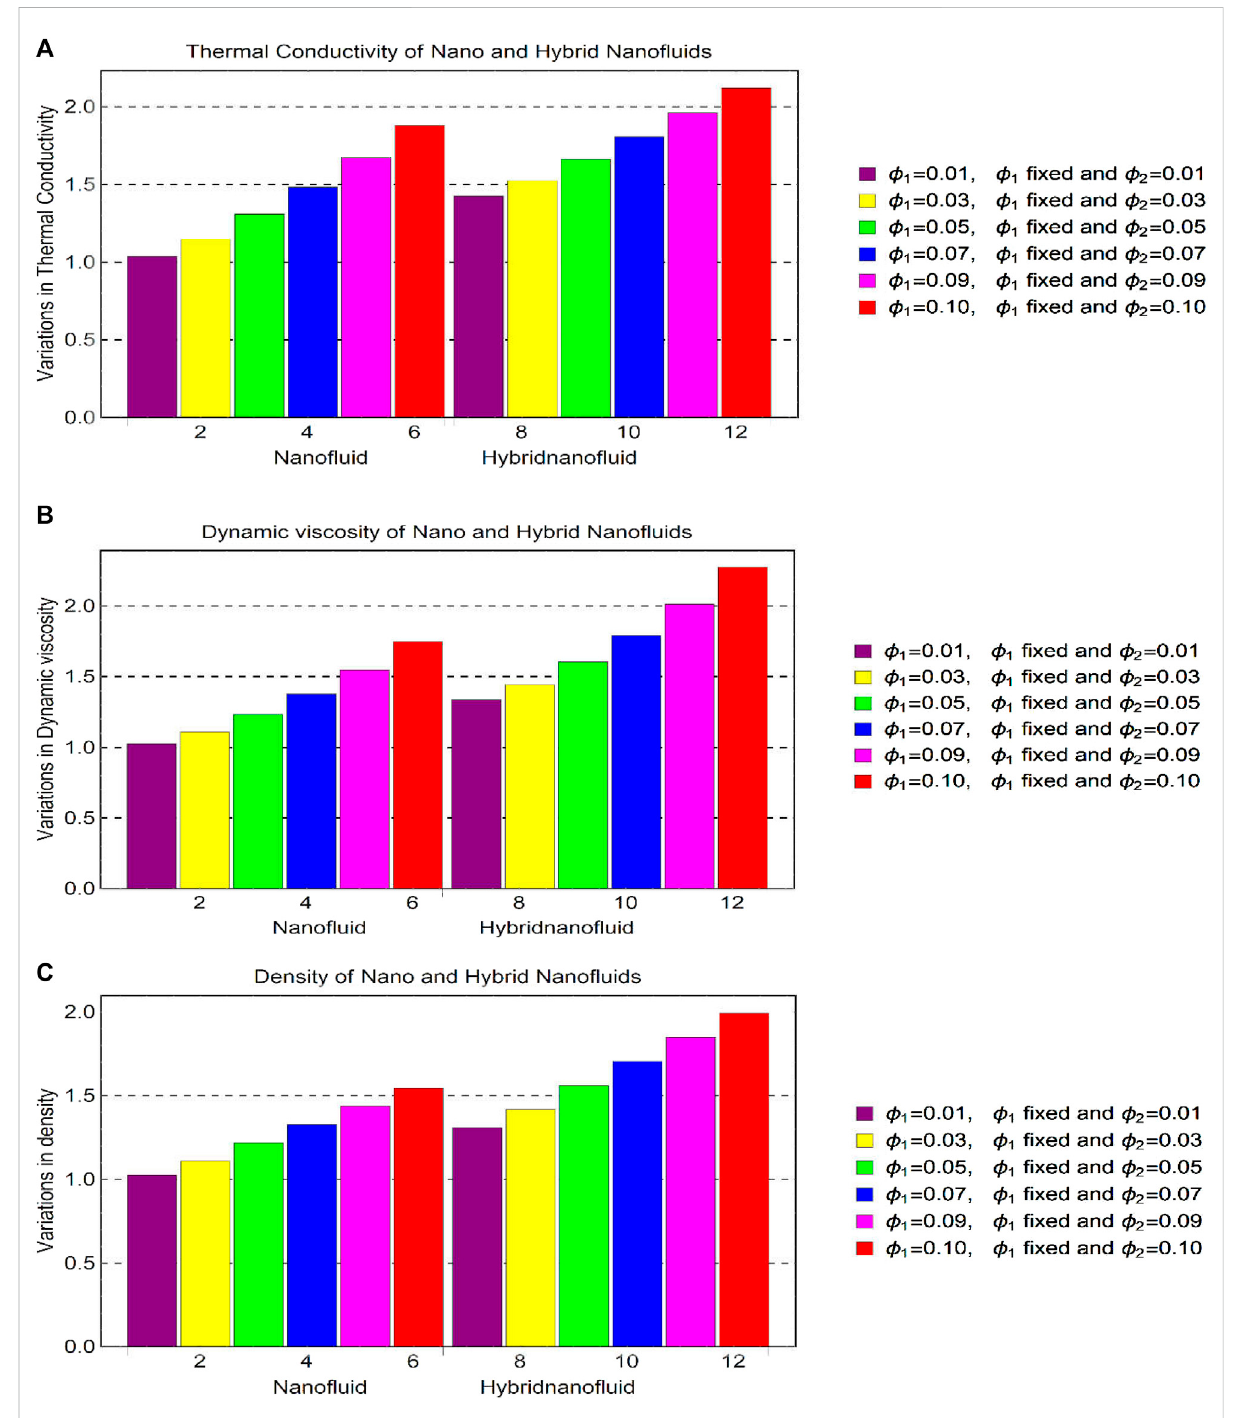
The changes in thermophysical values for (A) thermal conductivity (B) dynamic viscosity, and (C)